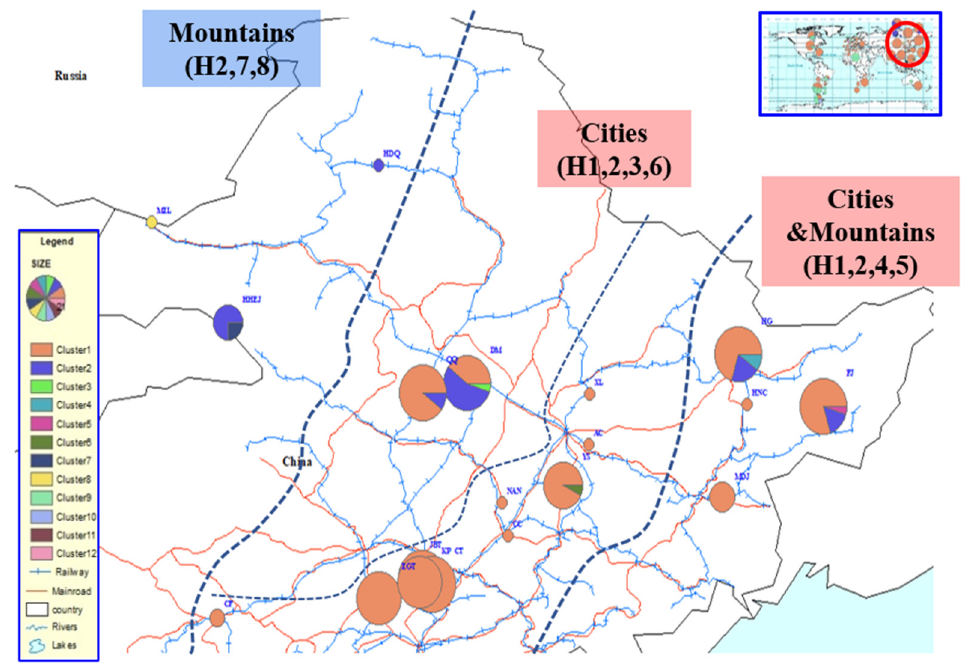
Figure 5. Chinese S. noctilio populations grouped by geographic proximity (west to east) and their haplotype projections.